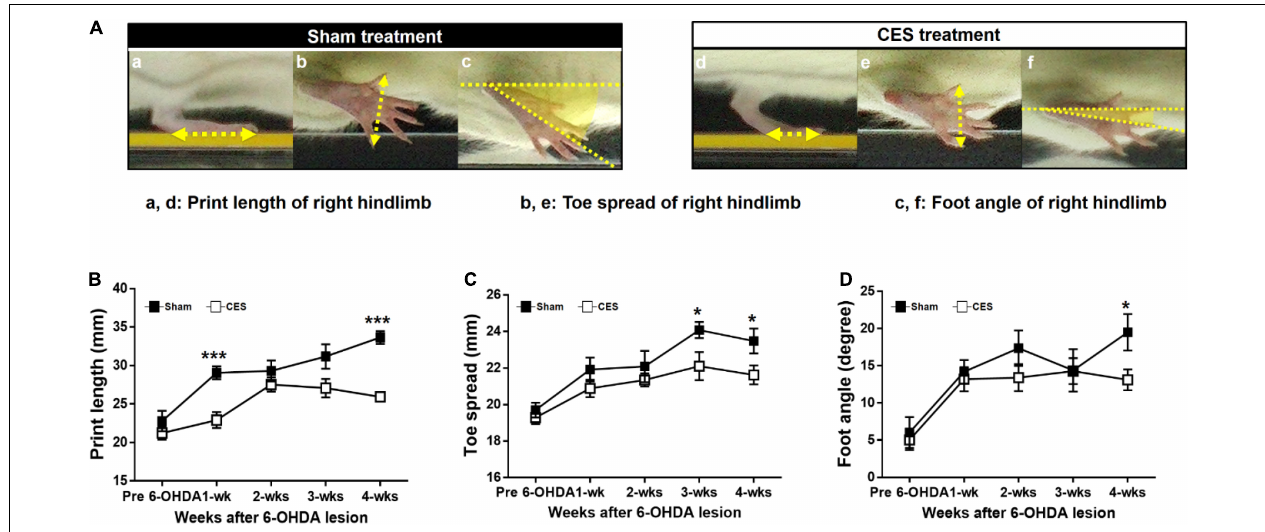
FIGURE 6 | Characteristics of footprint during walkway locomotion in PD rats with sham-treatment or CES treatment after 4 weeks PD lesion (A) . Time-course changes in print length (B) , toe spread (C) , and foot angle (D) in the sham- and CES-treated PD rats over 4 weeks of observation. Note that the print length, toe spread, and foot angle increased in the sham CES treatment group but less affected in the CES treatment group. * p < 0.05, ** p < 0.01, and *** p < 0.001, significant differences between two groups at each time point (unpaired t -tests).